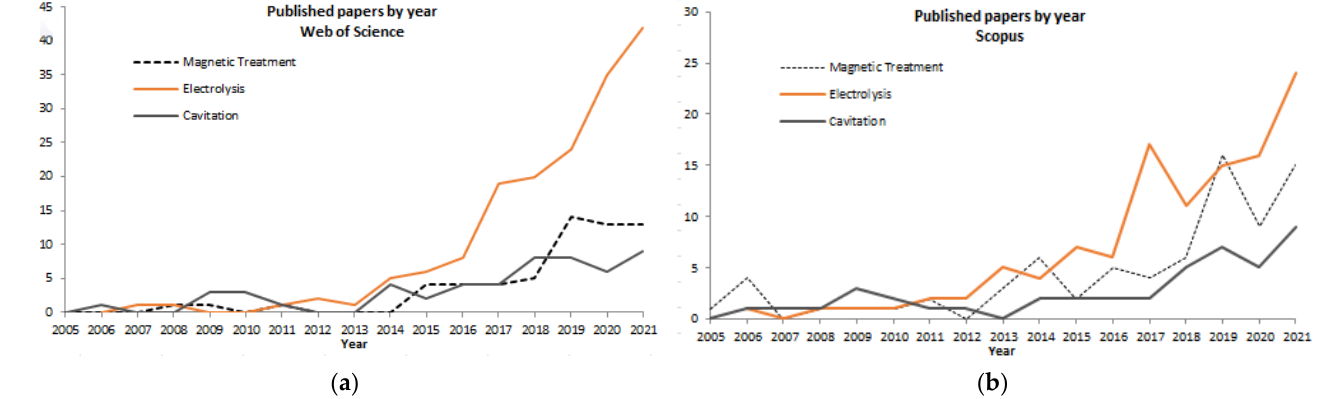
Figure 2. Research articles in the field of various methods of intensification of bioprocesses using the ( a ) Web of Science and ( b ) Scopus databases (2005 – 2021).